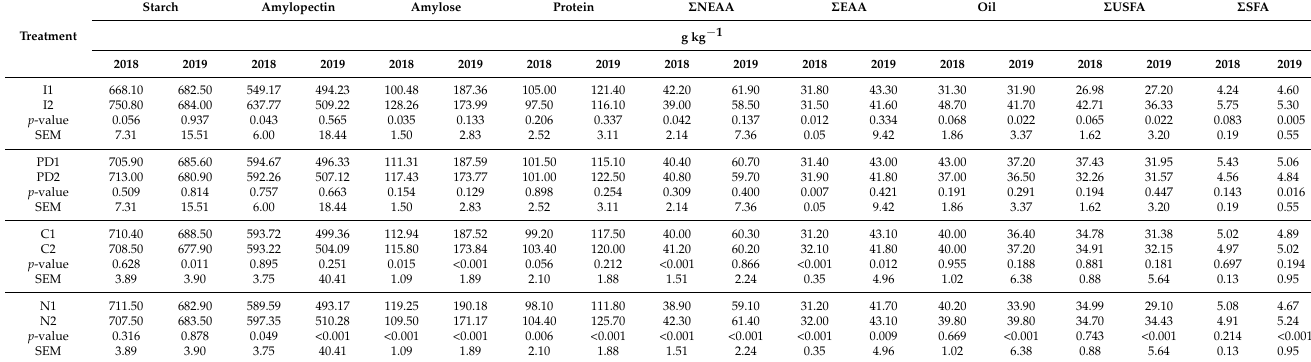
Table 3. Least square means, significances and standard errors of maize grain starch, amylopectin, amylose, protein, total nonessential amino acids ( Σ NEAA), total essential amino acids ( Σ EAA), oil, total unsaturated fatty acids ( Σ UFA) and total saturated fatty acids ( Σ SFA) in response to treatment main effects (irrigation, planting date, cultivar and nitrogen rate) in 2018 and 2019. Starch Amylopectin Treatment